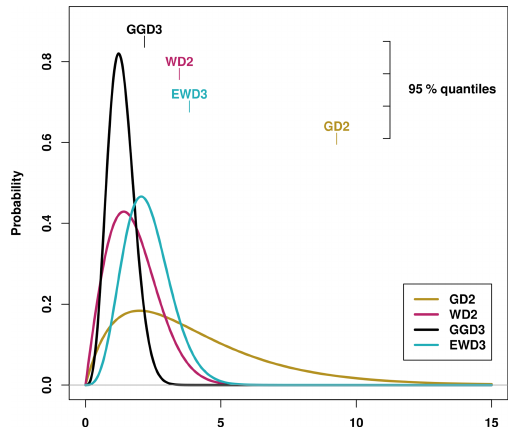
Figure 1. Candidate distribution functions whose performance is investigated in this study: the two-parameter gamma distribu- tion (GD2), the two-parameter Weibull distribution (WD2), the three-parameter generalized gamma distribution (GGD3), and the three-parameter exponentiated Weibull distribution (EWD3). Dis- played are examples of those PDFs for σ = γ( = α) = 2 and their corresponding 95%